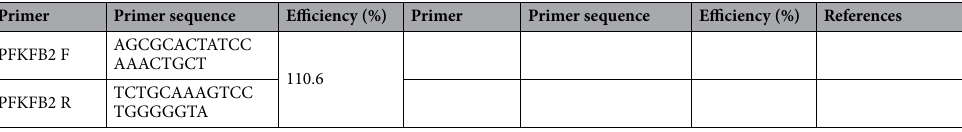
Table 2. Primer sequence and efficiency of the primer set for each